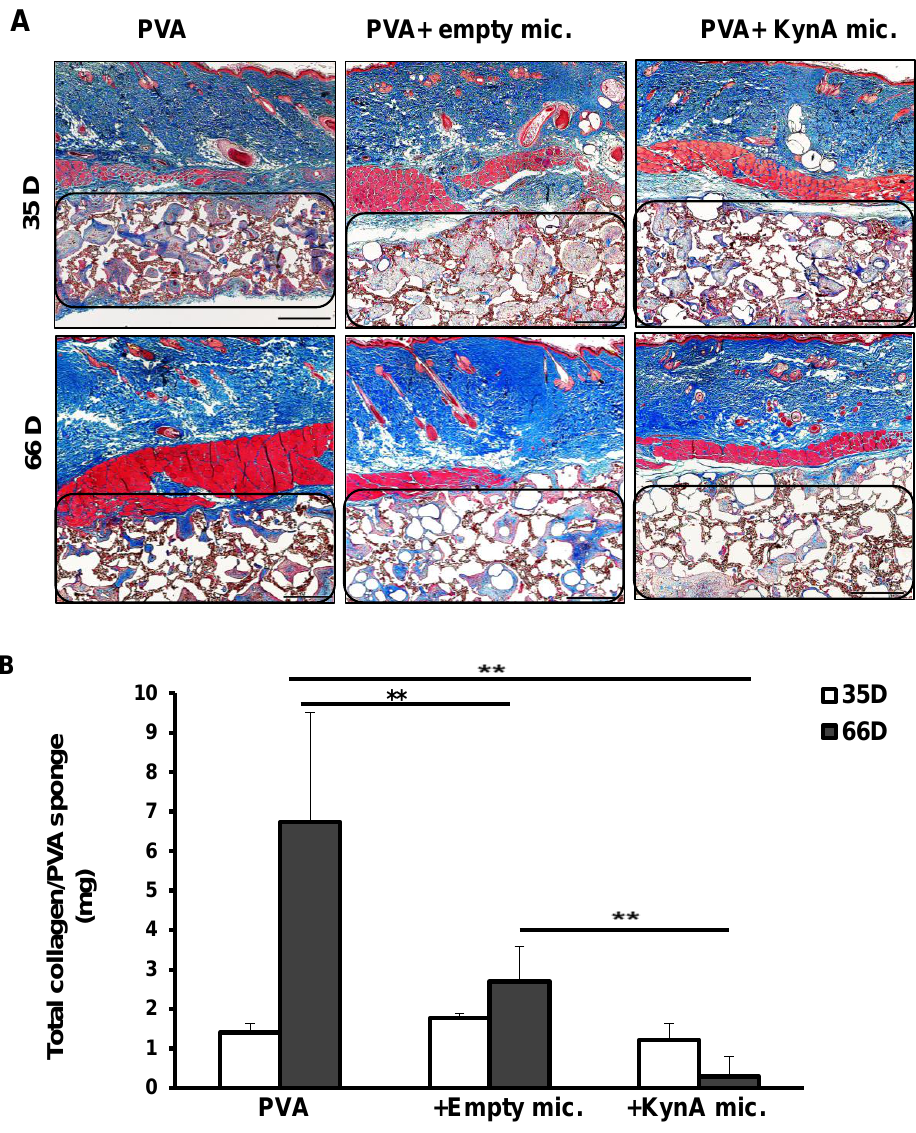
Figure 5. Biological effect of controlled release KynA on collagen deposition inside PVA sponges. ( A ) Masson’s trichrome staining of skin samples harvested at two time points (35 and 66 days)